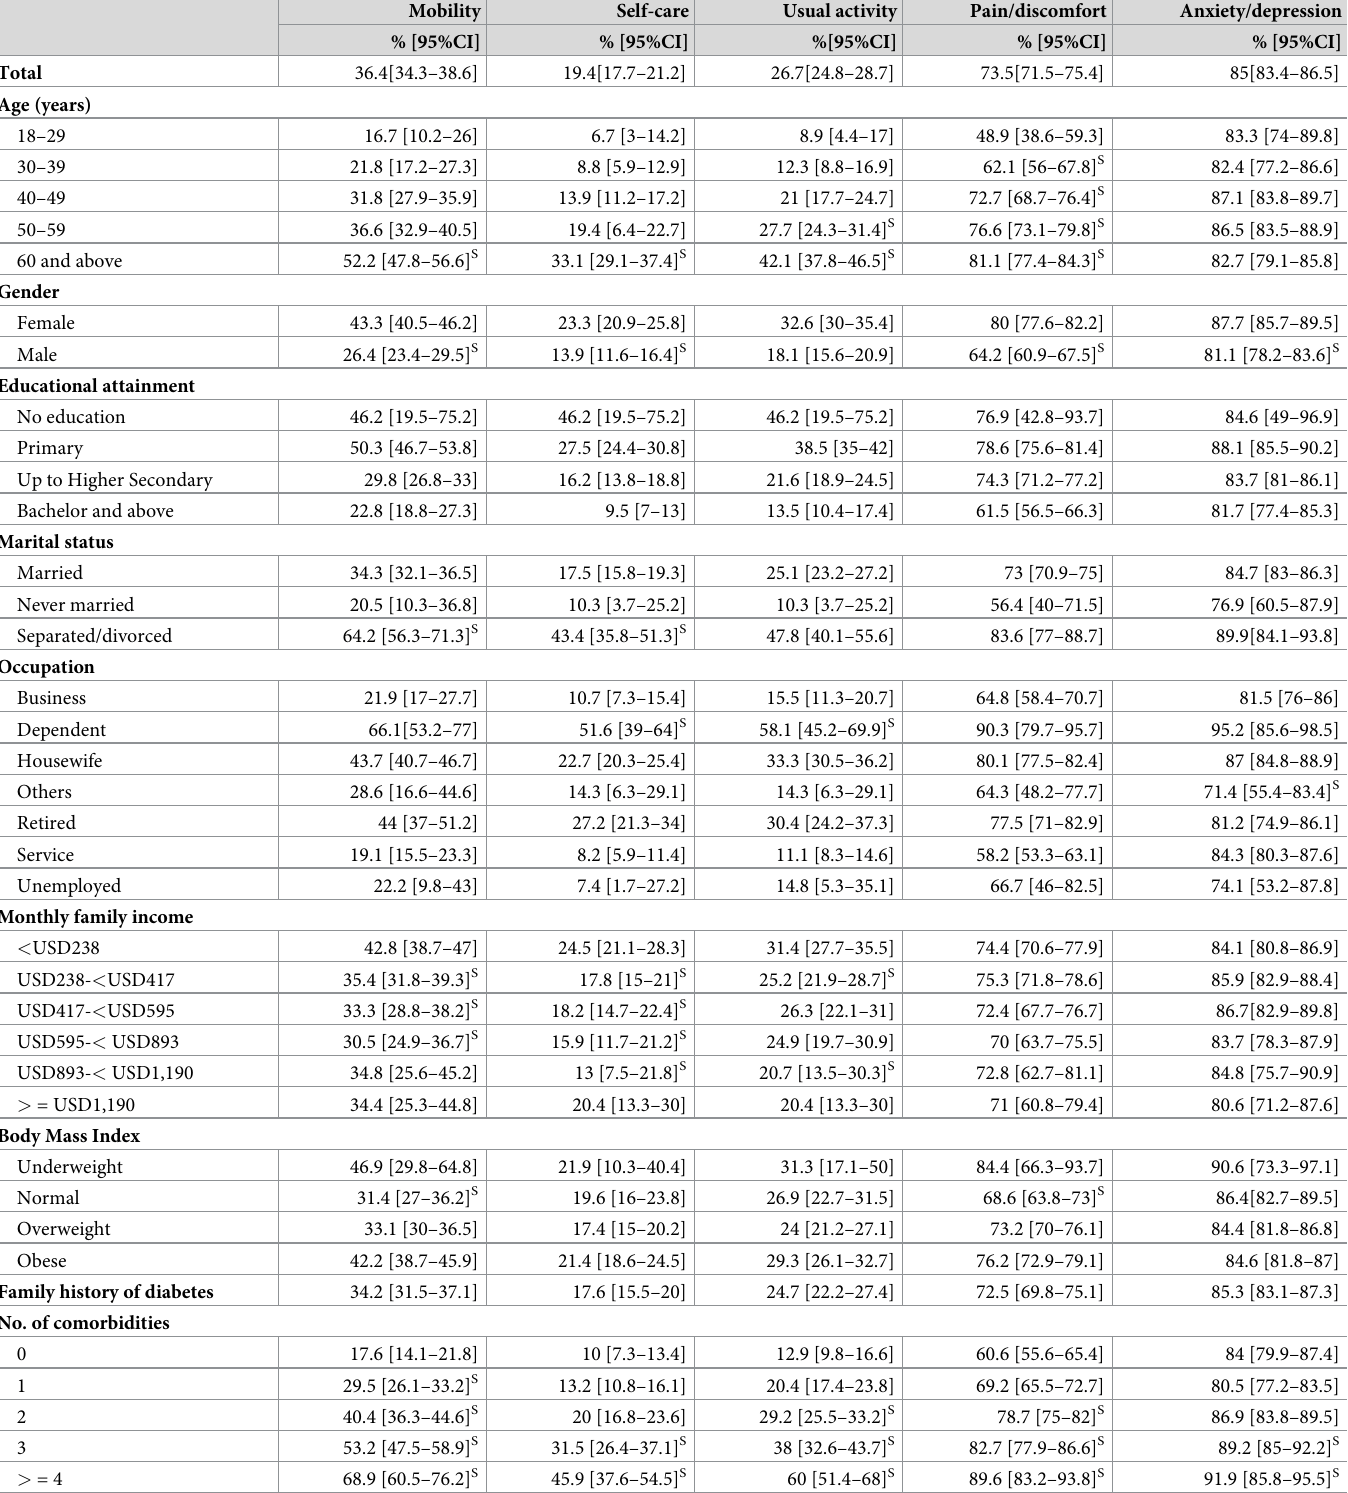
Table 2. Category-wise proportions of the five dimensions of EQ-5D